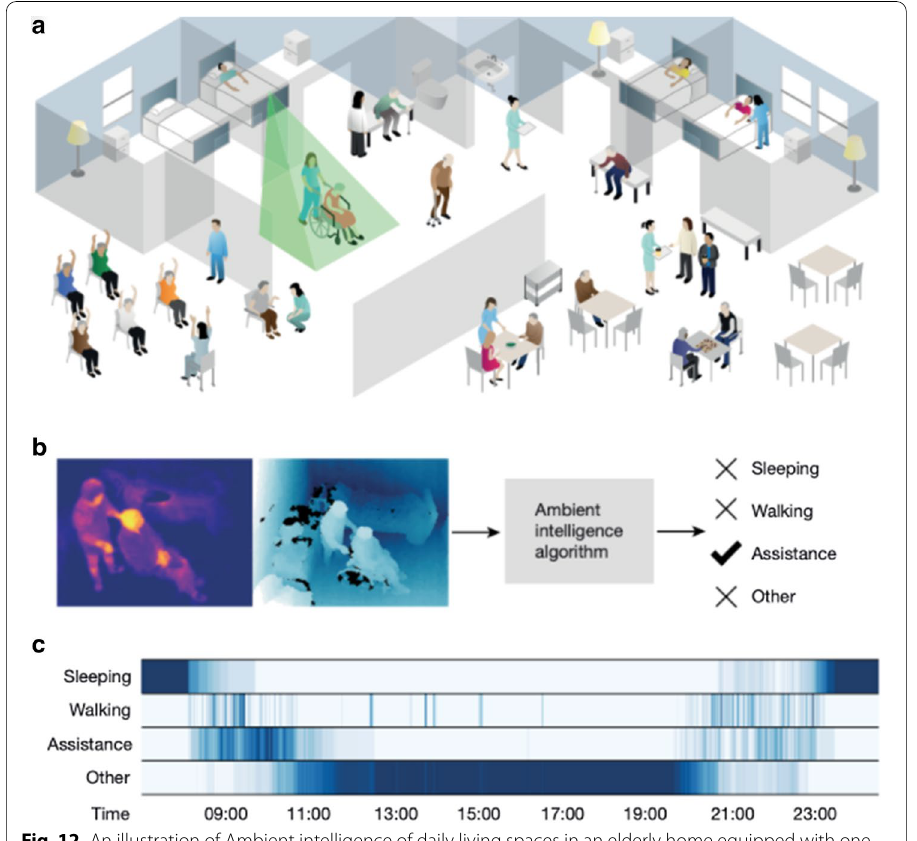
Fig. 12 An illustration of Ambient intelligence of daily living spaces in an elderly home equipped with one ambient sensor (Image taken from Haque et al.